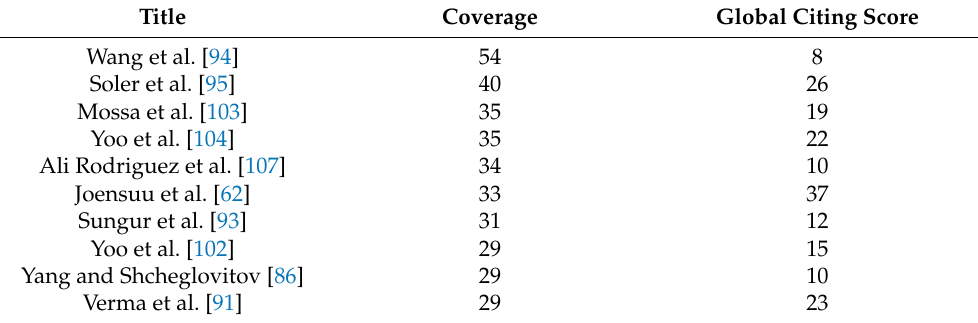
Table 6. Top 10 citing papers in Cluster #3 identified using